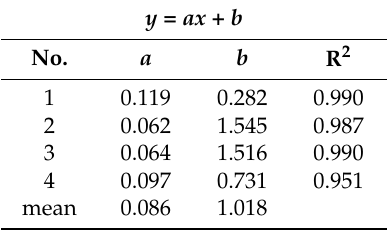
Figure 3. Anodizing potential of four silver plates; regression lines of 2 and 3 coincide. Table 6. Properties of the anodizing regression lines from Figure